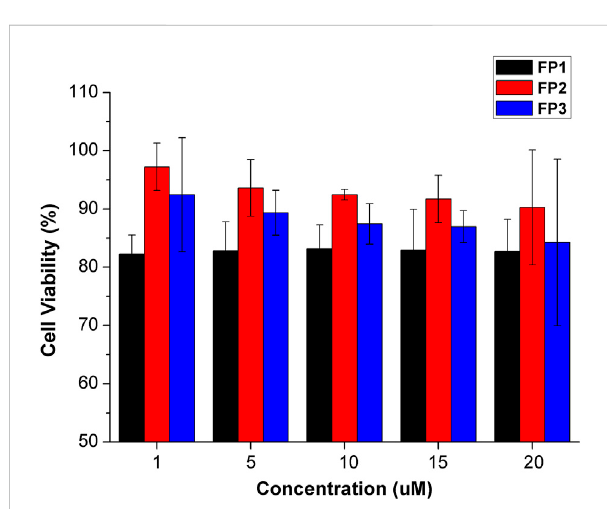
FIGURE 2 Viability of cells treated with probes FP1 – FP3 at concentrations of1,5,10,15,20 μ M.Cell viability wasassessedbyMTTassay. Data are the mean ± S.D. of fi ve independent